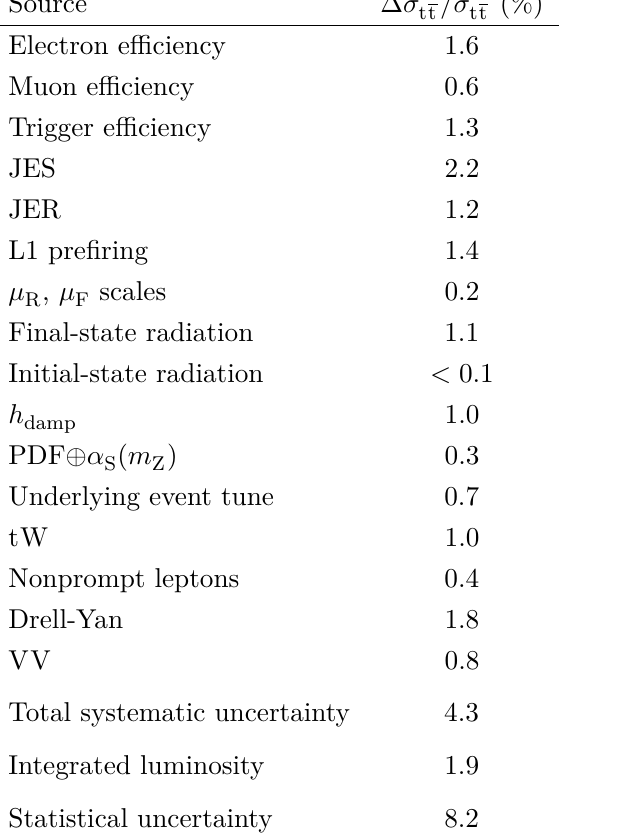
Table 2 . Summary of the systematic and statistical relative uncertainties for the inclusive tt cross section